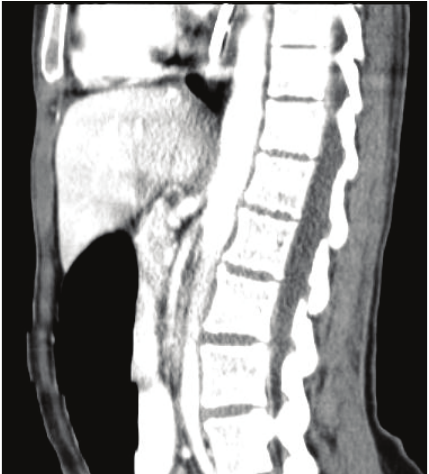
Figure 1: Cross-sectional imaging demonstrating the reduced aortic-mesenteric artery angle.